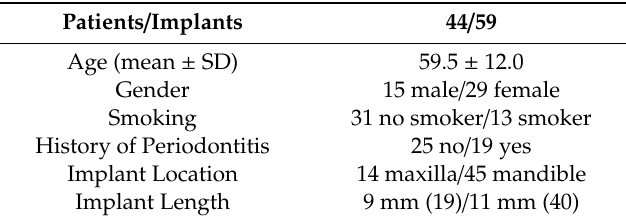
Table 1. Baseline patient and intervention